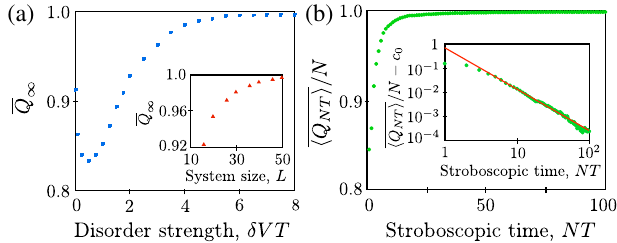
FIG. 6. Quantized charge pumping in the AFAI. (a) Cumulative average of the pumped charge per cycle in the limit of long times, ¯ Q ∞ [cf. Eq. (15)], as a function of disorder strength. For the localization length is sufficiently smaller than the system size, ¯ Q and ∞ approaches unity. The inset shows the finite-size scaling ¯ Q δ VT ¼ 8 . (b) Cumulative average of the pumped of ∞ for charge for N periods, h Q i NT =N , as a function of N . The disorder strength we use is δ VT ¼ 8 . The approach to the quantized value can be fit to a power law ð NT Þ − υ with υ ¼ 1 . 72 ; see the log-log plot shown in the inset. In both panels, we average the charge pumped across all the lines running parallel to the y direction of the cylinder (see Fig. 3) and over 100 disorder realizations. The system size is L x × L y ¼ 50 × 50 .